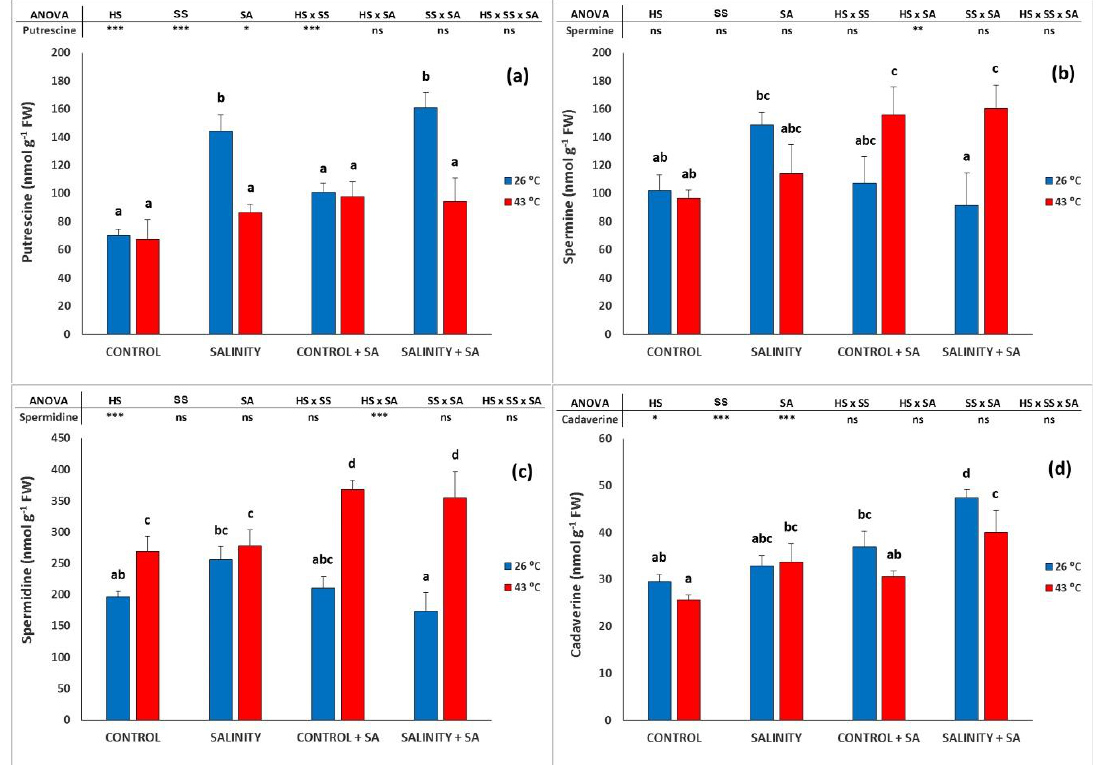
Figure 4. Effect of heat-shock and salinity, with or without salicylic acid, on the polyamines (putrescine ( a ), spermine ( b ), spermidine ( c ), and cadaverine ( d )) in the leaves of pepper plants. The * refers to significant differences at the level of p ≤ 0.05; ** p ≤ 0.005; *** p ≤ 0.001; n.s., not significant. Different lowercase letters denote significant differences between columns, p < 0.05. HS is heat stress; SS is salinity stress; SA is salicylic acid.